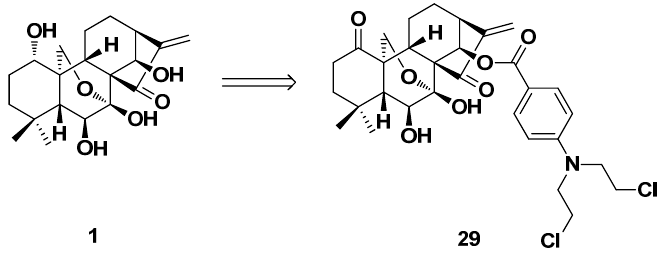
Figure 13. The hybrid of oridonin and nitrogen mustard ( 29 ).